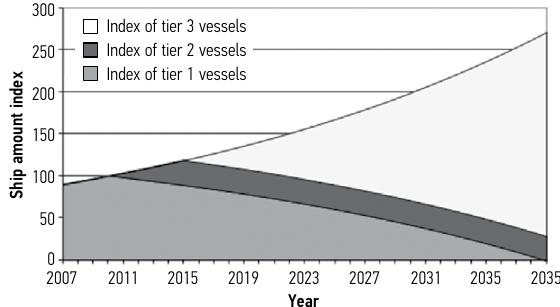
Fig. 4. Changes in the structure of the Gulf of Finland ship fleet over time due to the introduction of Tier II and Tier III. The annual growth rate is assumed to be 3.5% with 2% used for the renewal